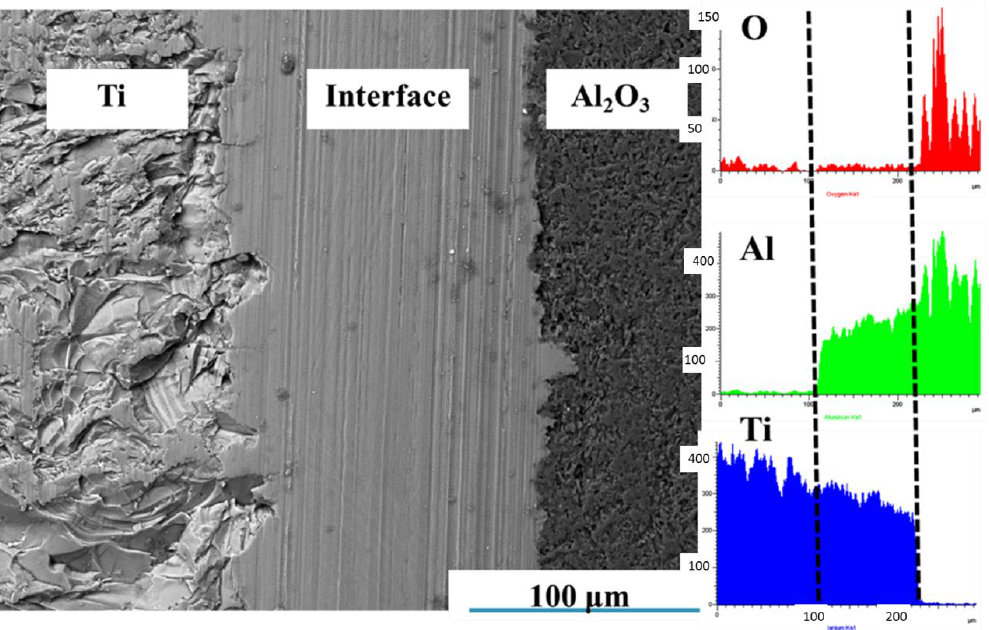
Figure 6. SEM images and line scanning analysis of the interface at 1500 °C holding for 1.5 h.